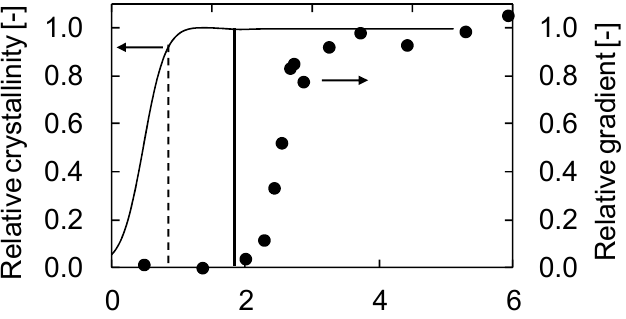
Figure 5. Comparison between relative gradient and relative crystallinity in